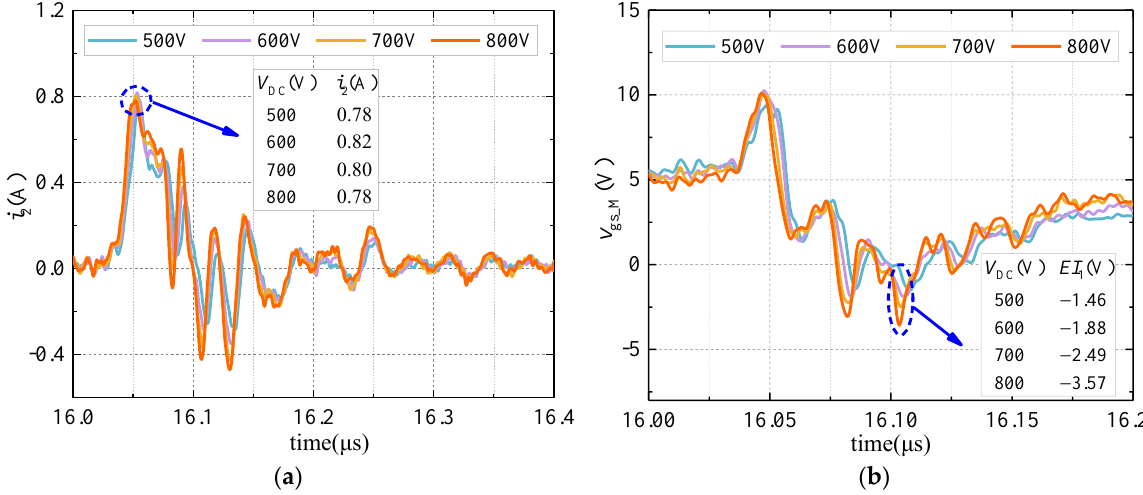
Figure 10. The current waveform flowing through V cc and the gate−source voltage waveform of M under higher voltages. ( a ) Current waveform; ( b ) voltage waveform.